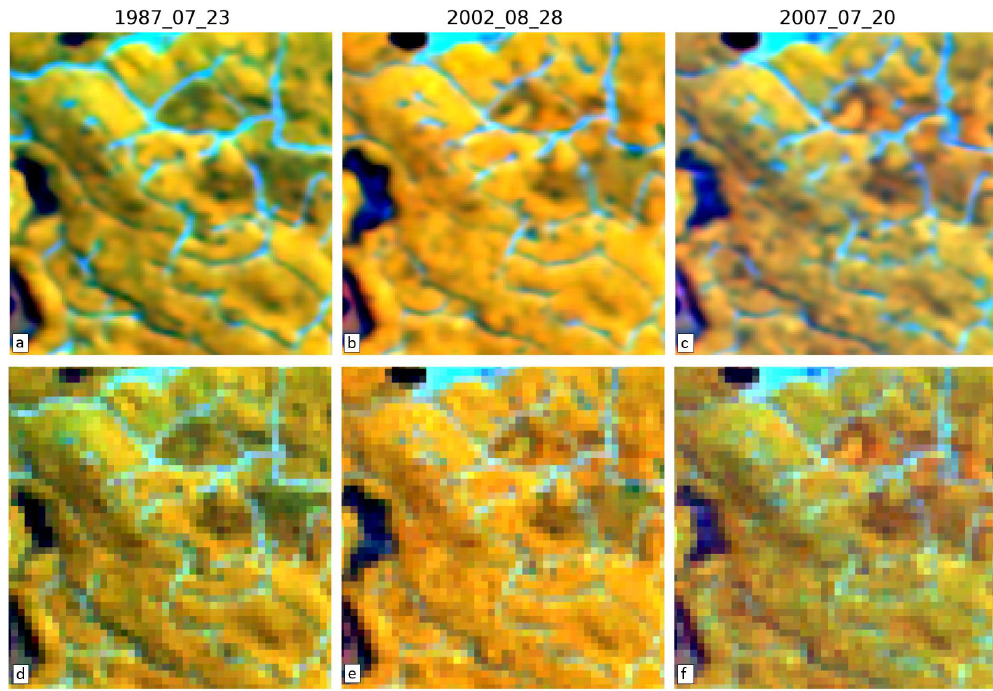
Figure 7. Example temporal extension result for a broadleaf forestarea. ( a,b,c ) is the spatially enhanced result and ( d,e,f ) is the original Landsat.